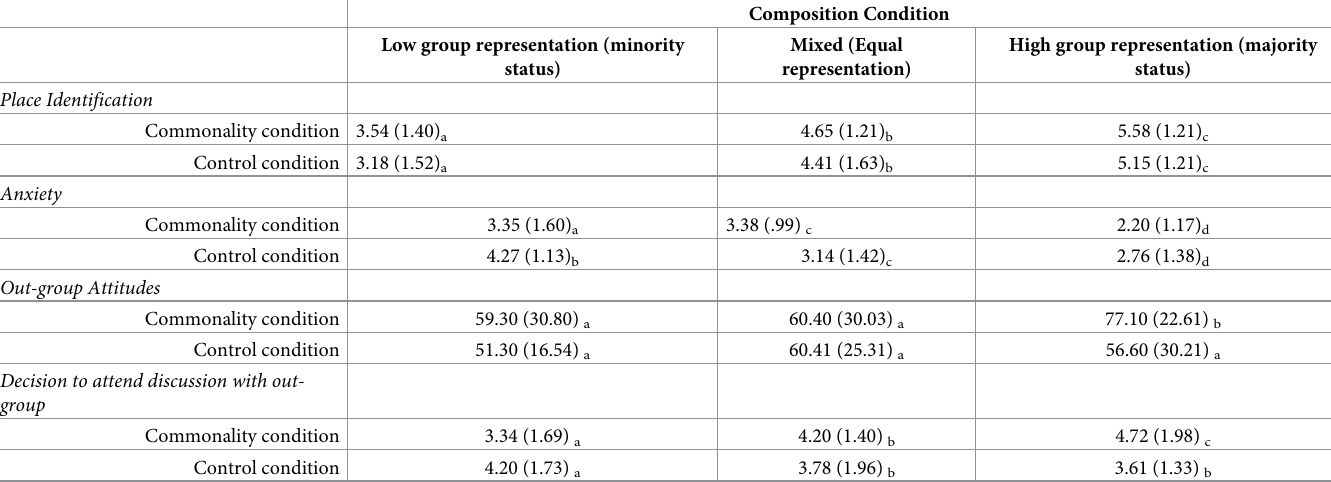
Table 8. Tests for the effects of identity emphasis and group representation on outcome variables (Study